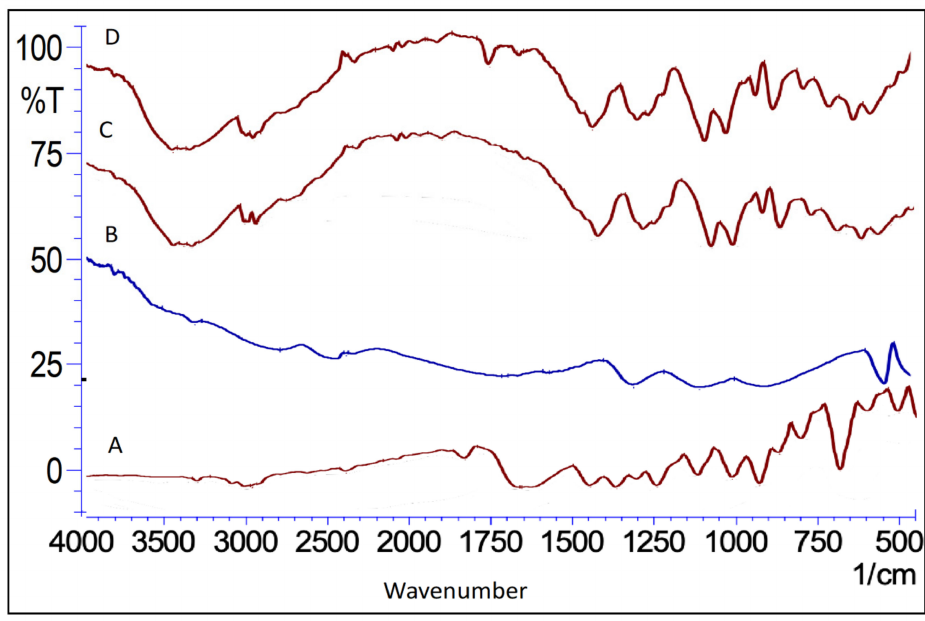
Figure 7. Overlay spectra showing the FTIR of ( A ) TQ, ( B ) FA, ( C ) mannitol, and ( D ) FTQ-NE.